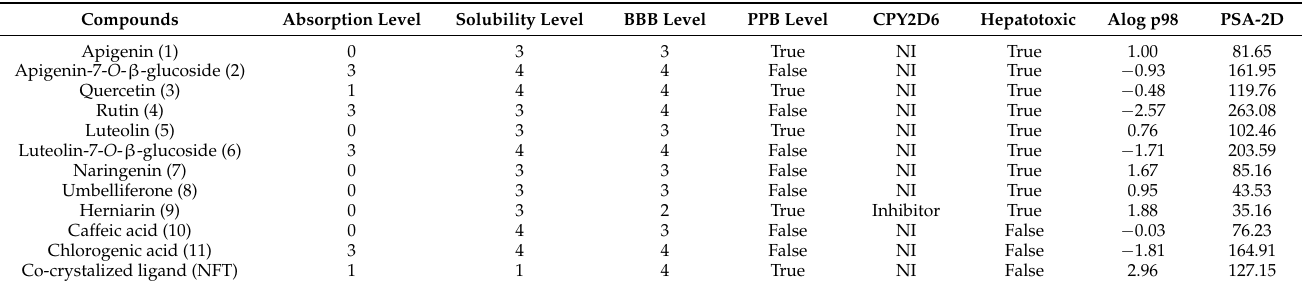
Table 3. Absorption, distribution, metabolism, excretion, and toxicity (ADMET) properties of the major polyphenolic compounds of Matricaria chamomilla flowers.